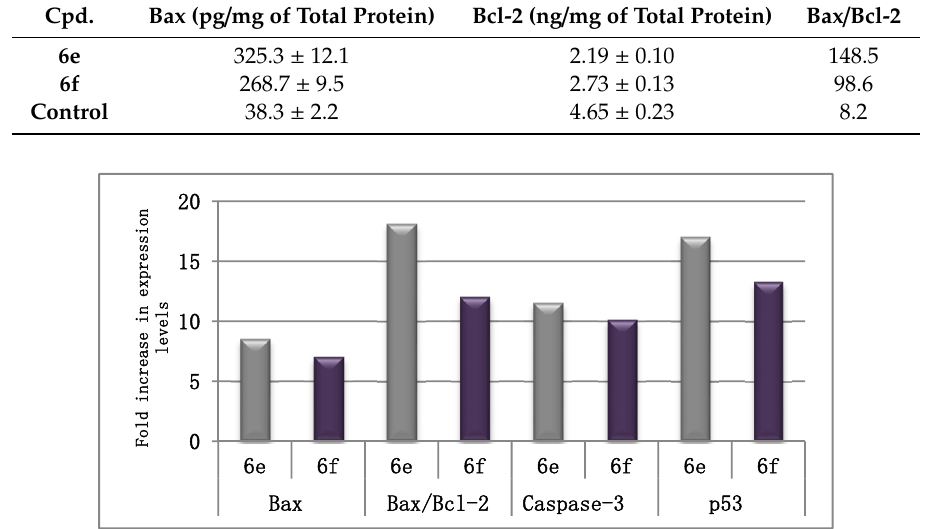
Table 4. Effect of compounds 6e and 6f on the expression levels of active caspase-3 and p53 in MCF-7 Table 3. E ff ect of conjugates 6e and 6f on the expression levels of Bcl-2 and Bax in MCF-7 cancer cells. cancer cells. Cpd.